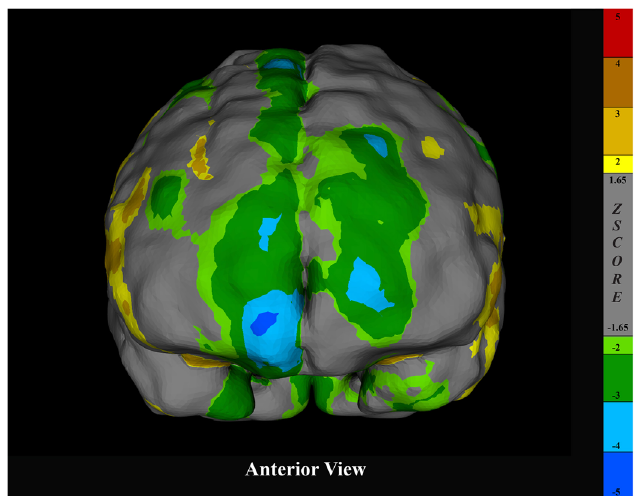
Figure 10. Surface projection of a brain SPECT scan rendered in CereMetrix ® demonstrating frontal hypoperfusion in a person with suspected